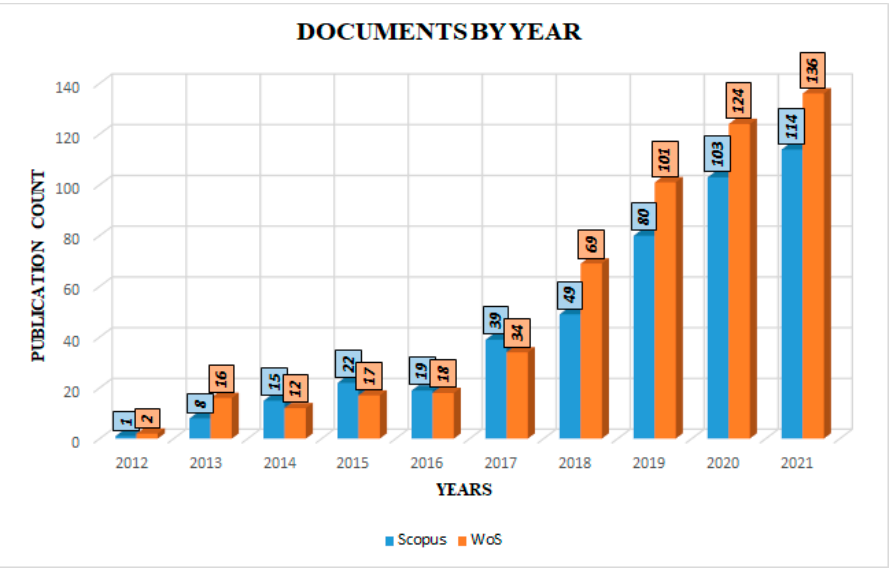
Figure 8. Year-wise number of documents published in Scopus and WoS.